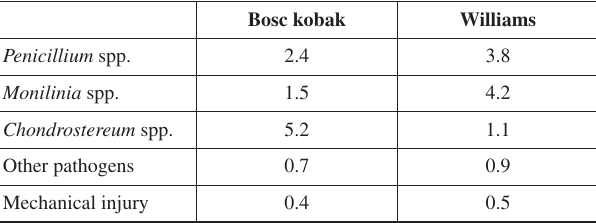
Table 3. Types of postharvest damage on two pear cultivar uner traditional cold storage condition (Nagykanitsa, 2010)